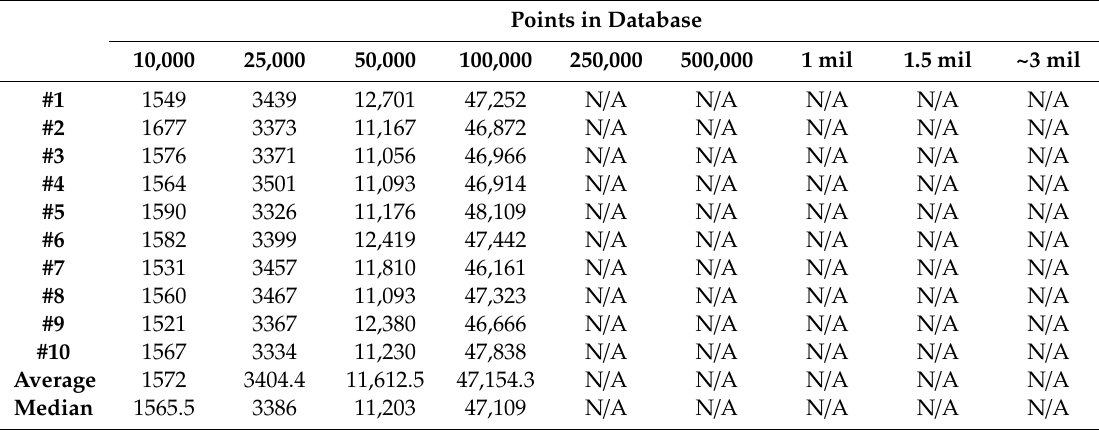
Table 2. Results of testing Leaflet.markercluster library (values in milliseconds).